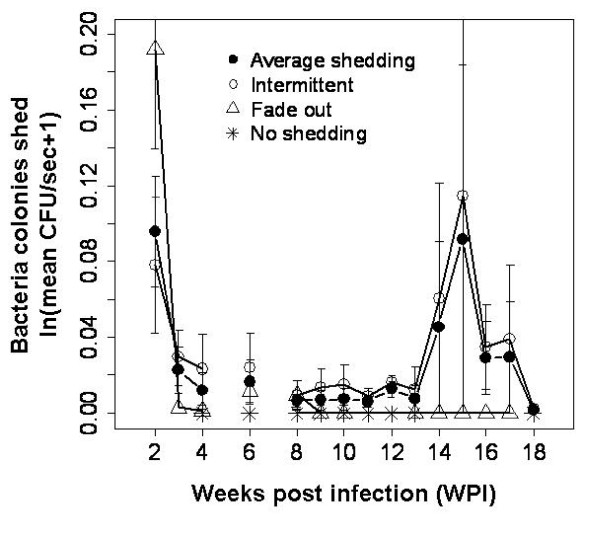
Mean number of bacteria shed (CFUs/sec ± S.E.) by oro-nasal contact with a BG blood agar plate during the course of the infection. A total of 14 infected rabbits were used and sacrificed at days 60, 90, 120 and 150 post-infection. Each individual was weekly challenged by oro-nasal contact with a BG blood agar plate and time of interaction measured. Bacteria were enumerated after incubating for 36-48 hr at 37°C. For every week post infection (from WPI 2 to WPI 18) the number of plates positive for B. bronchiseptica after removal of contaminated cases and sacrificed individuals was: WPI 2 = 8, WPI 3 = 6, WPI 4 = 8, WPI 5 = N.D. (no data), WPI 6 = 11, WPI 7 = N.D., WPI 8 = 14, WPI 9 = 12, WPI 10 = 12, WPI 11 = 12, WPI 12 = 12, WPI 13 = 8, WPI 14 = 8, WPI 15 = 8, WPI 16 = 8, WPI 17 = 8, WPI 18 = 4. The overall average shedding pattern and the more specific three shedding groups (intermittent, fade-out and non-shedding) are reported.